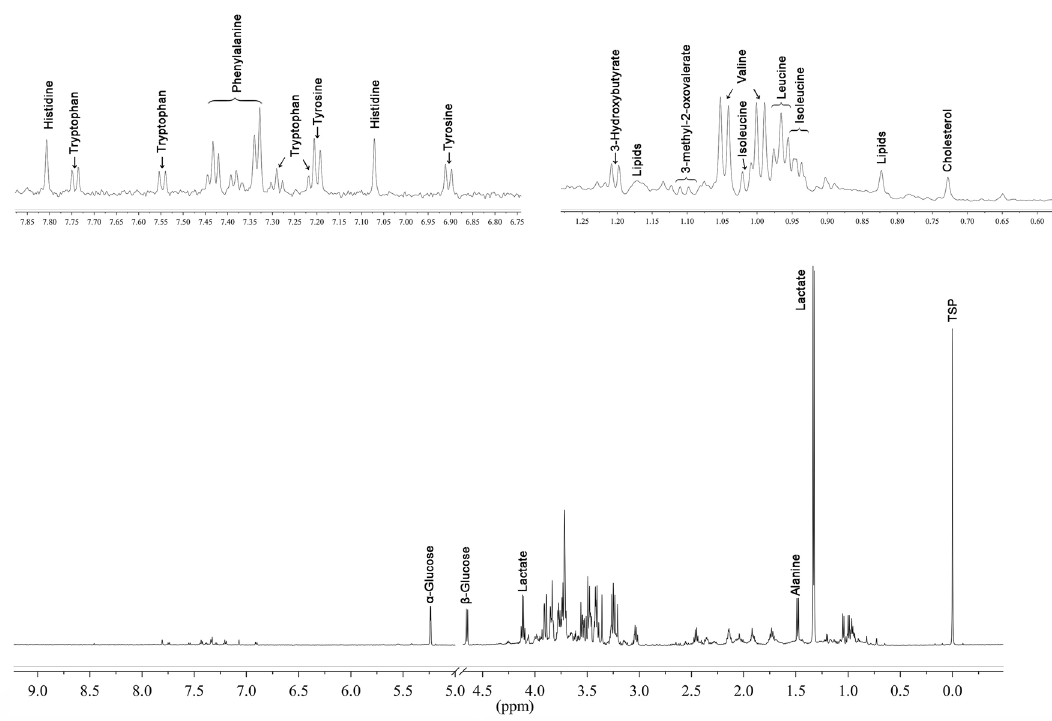
Figure 1. Typical 1 H-NMR spectrum of serum after methanol extraction following cpmgpr pulse sequence with expanded regions; the region between 3.25 and 4.00 ppm is occupied by sugar resonances. Major metabolites are assigned over the spectrum